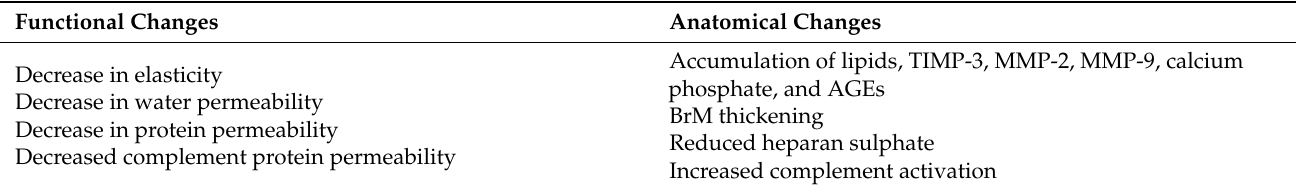
Table 1. Summary of functional and anatomical changes in BrM with age. Anatomical Changes